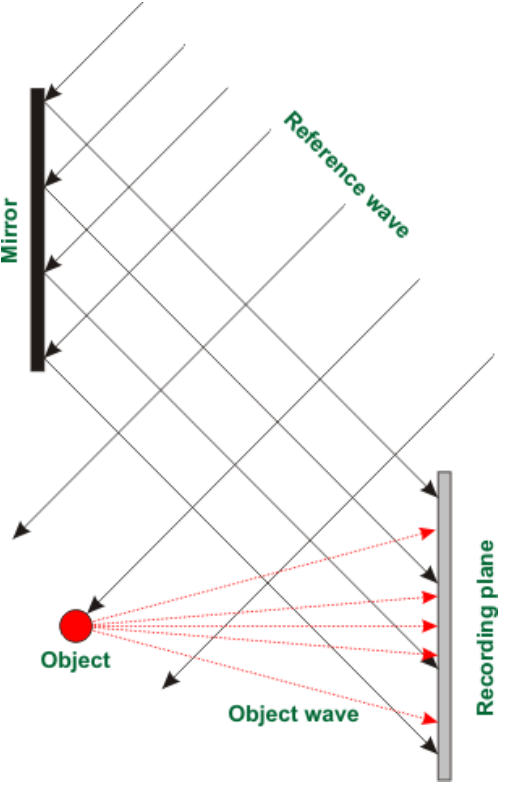
Figure 3. Schematic optical holography using an inclined beam (e.g., laser).